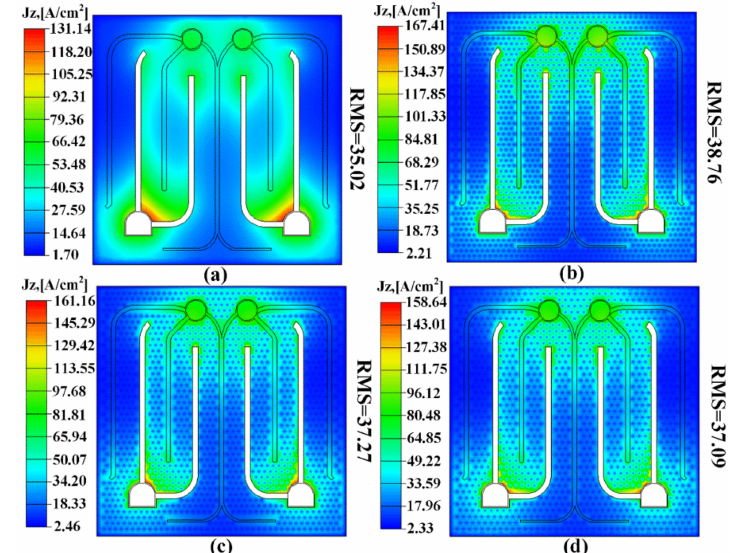
Figure 6. SimuLED simulation of the current density distribution in the active region of UV LED at 350 mA: ( a ) UV LED I; ( b ) UV LED II; ( c ) UV LED III; ( d ) UV LED